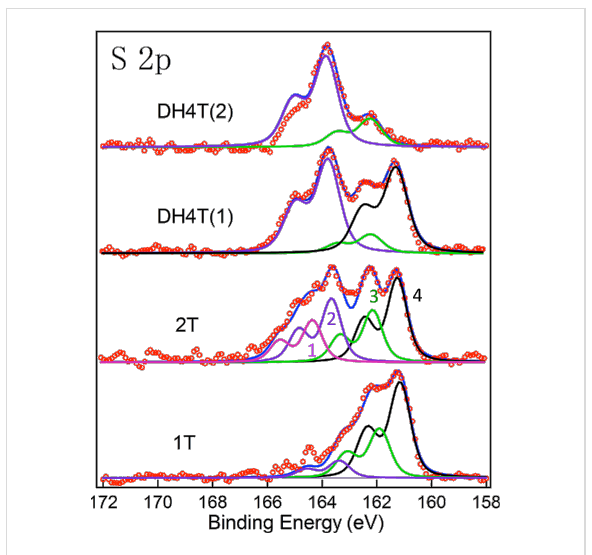
Figure 7: XPS S 2p spectra for 1T, 2T and DH4T adsorption on Au films on mica. The DT spectra are shown for two different samples pre- pared in the same